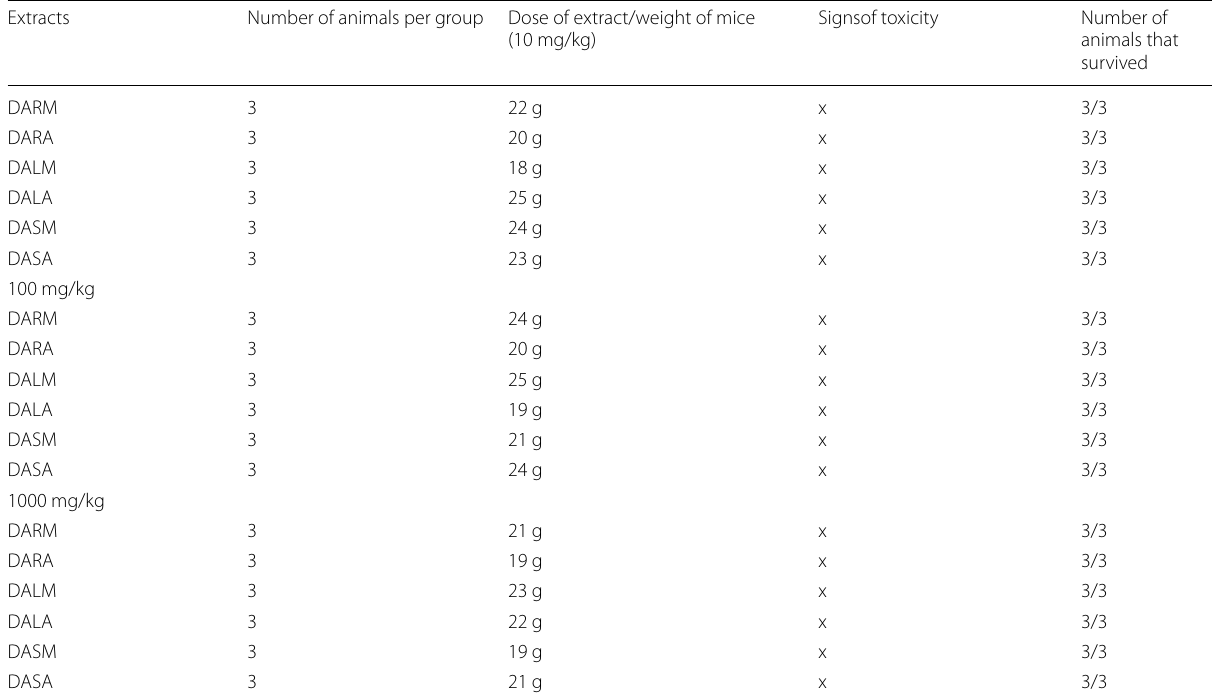
Table 2 Acute toxicity test of the aqueous and methanolic extracts of the roots, leaves, and stem of Dictyandra arborescens at doses of 10, 100 and 1000 mg/kg body